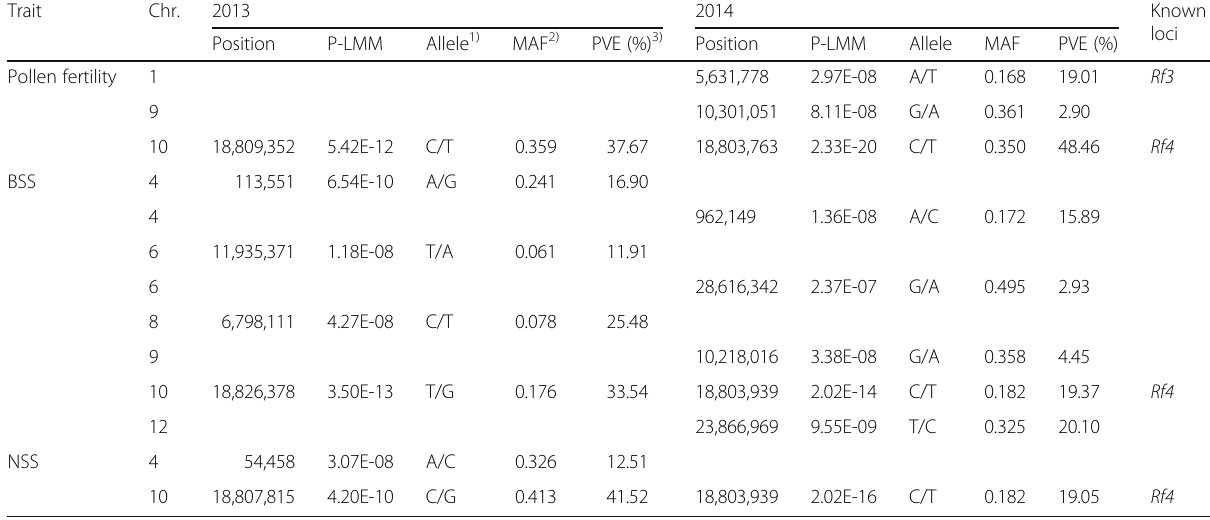
Note: 1) Allele is presented with the format of ‘ major allele / minor allele ’ 2) MAF minor allele frequency 3) PVE phenotypic variation explained by each